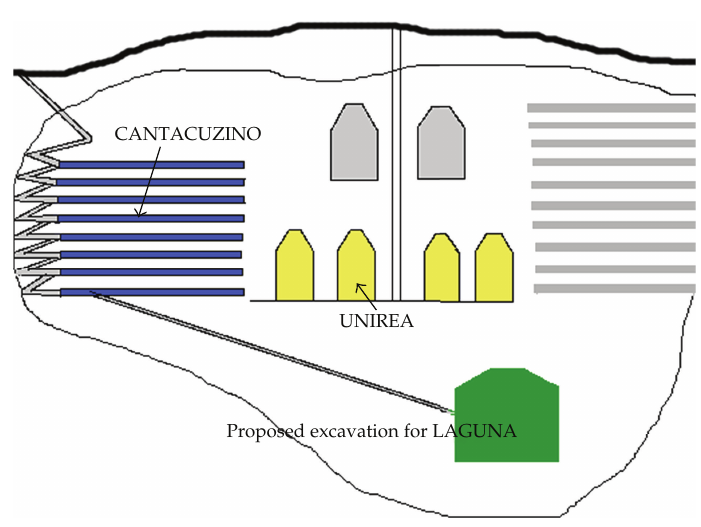
Figure 1: An artistic representation of the salt mine in Slanic, Romania (cid:3) color online (cid:4)